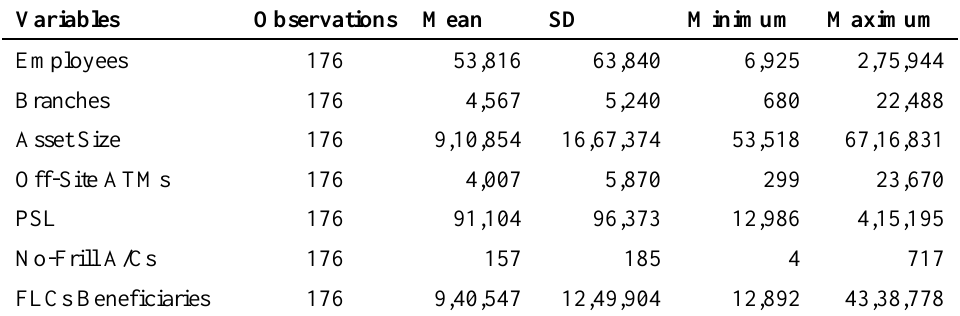
Table 1: Descriptive Statistics